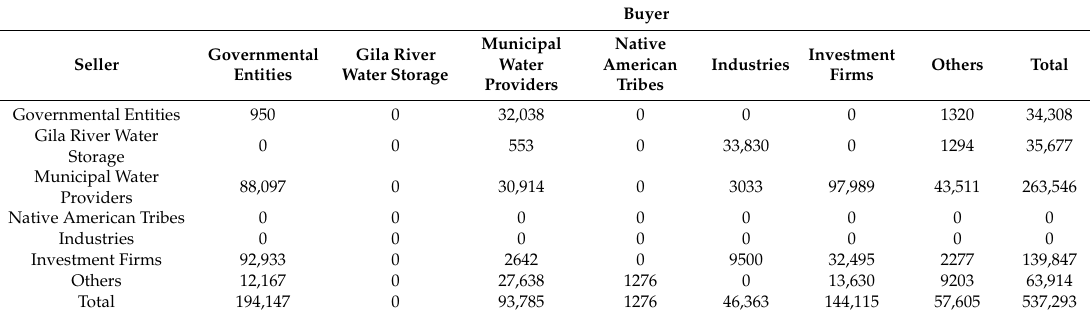
Table 3. Volume of Arizona long-term storage credit transactions in the Phoenix AMA, from seller to buyer, from 1994 to 2016.